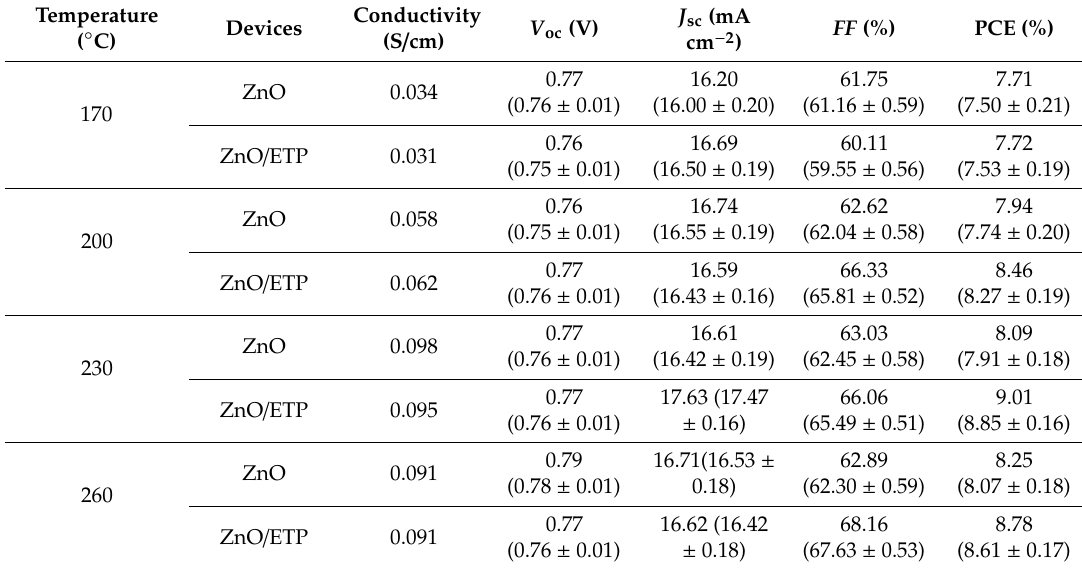
Table 1. Photovoltaic performance parameters of the devices based on PTB7-Th–PC 71 BM blends,